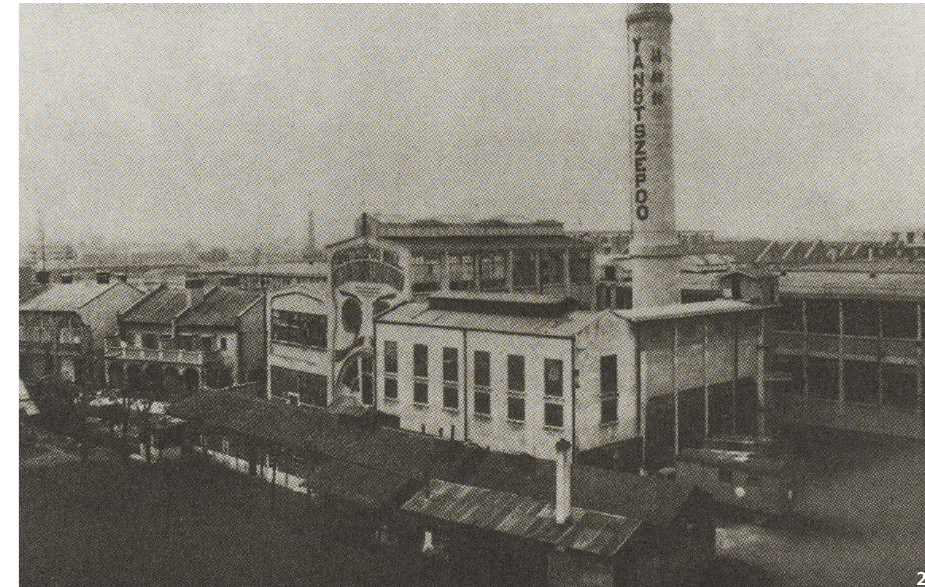
Figure 2 Yangtzepoo (Yang- shupu) Mill, c. 1920s (Source: